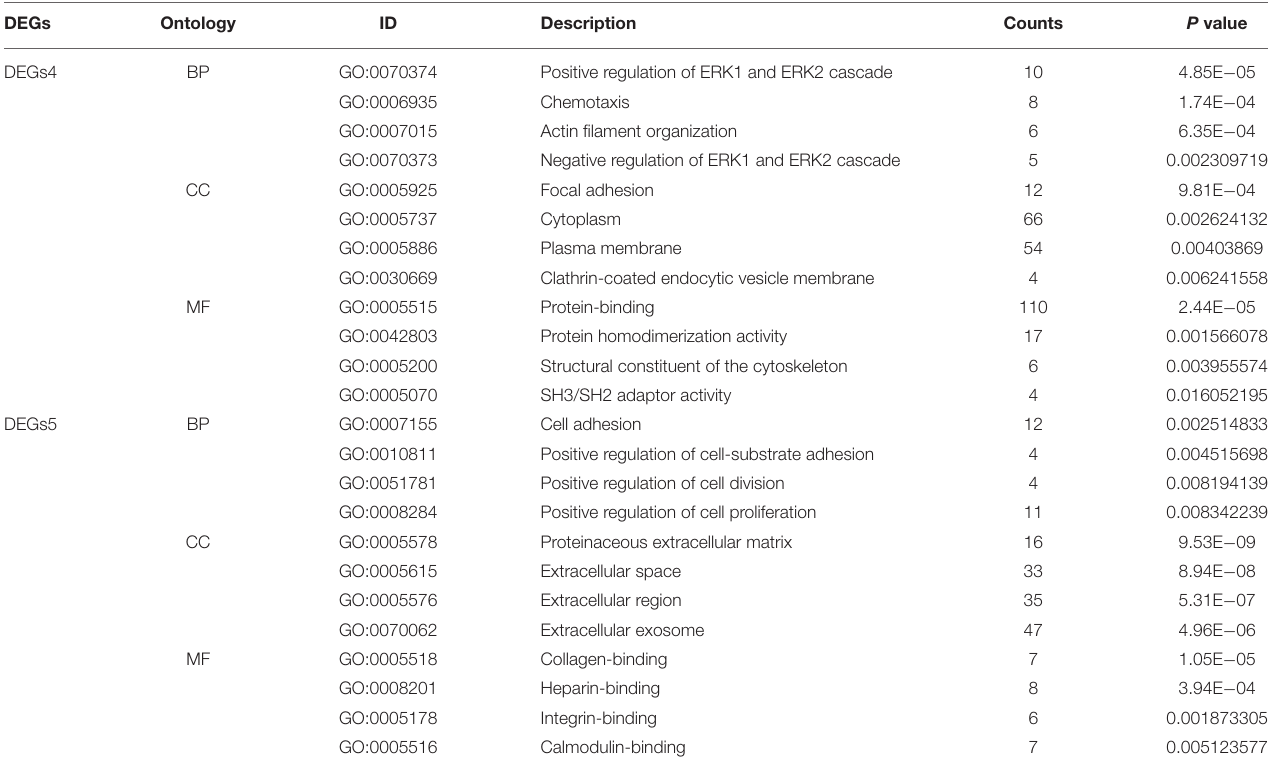
TABLE 1 | The gene ontology (GO) enrichment analysis of independent differentially expressed genes (DEGs) in hypertrophic cardiomyopathy (HCM) and dilated cardiomyopathy (DCM). DEGs Ontology ID Description Counts P value